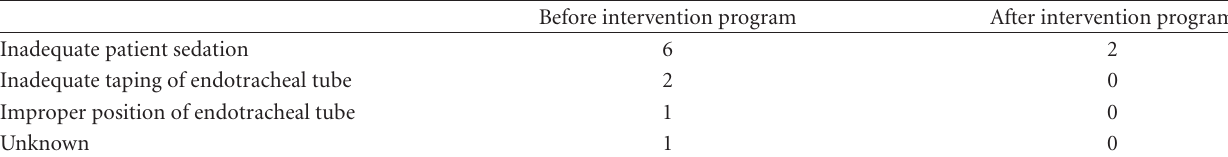
Table 2: Reasons for the unplanned extubation.